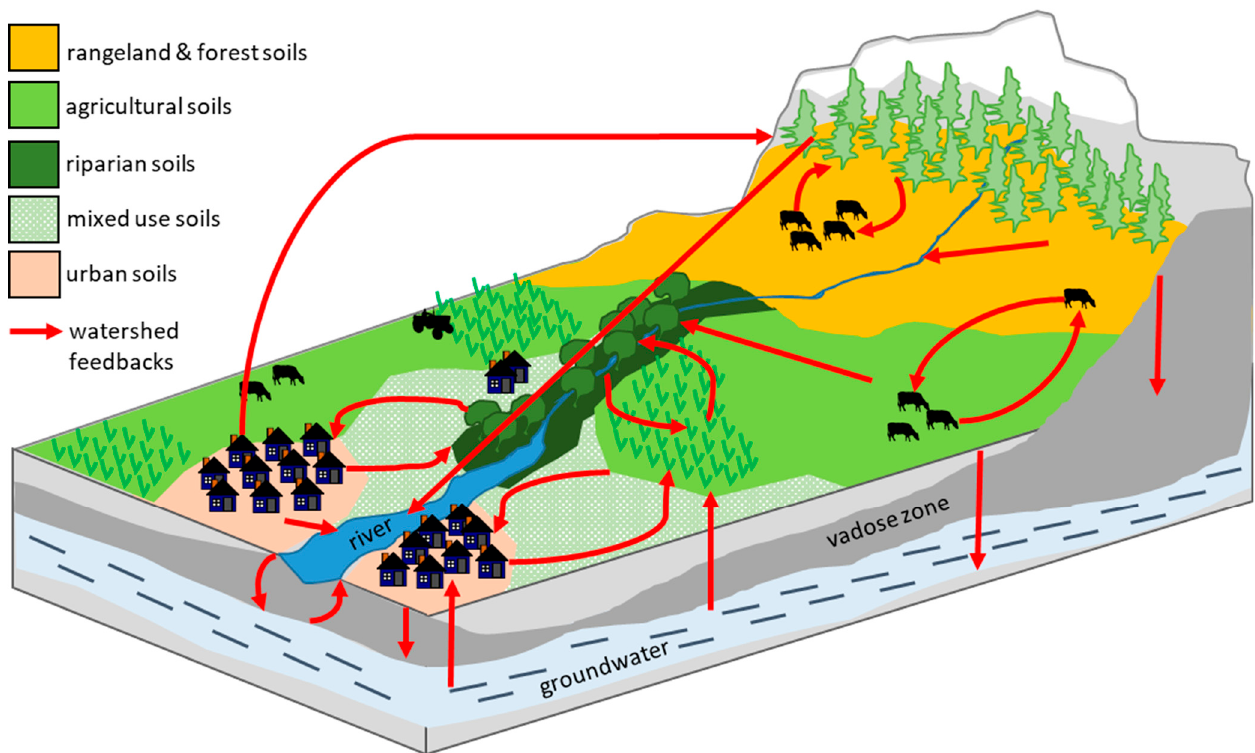
Figure 5. Schematic representation illustrating watershed-level socio-economic feedback pathways that may exist to alter soil system dynamics through economic, conservation, recreation, or other behaviors, depending on the goals and objectives of decision makers and their perceived conditions of soil resources (inspired by [48]).